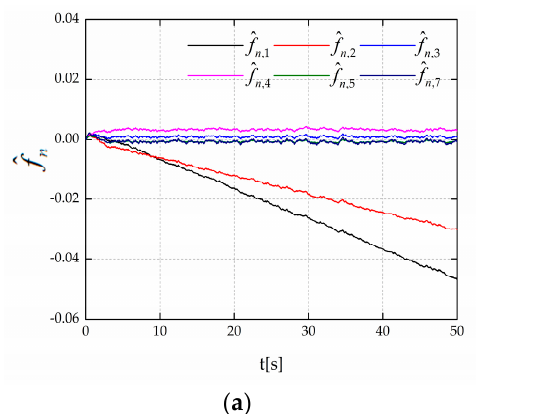
Figure 13. Sensor fault reconstruction in Mode 4: ( a ) Robust sensor fault reconstruction ˆ f ( b ) ˆ f reconstruction without robust design.